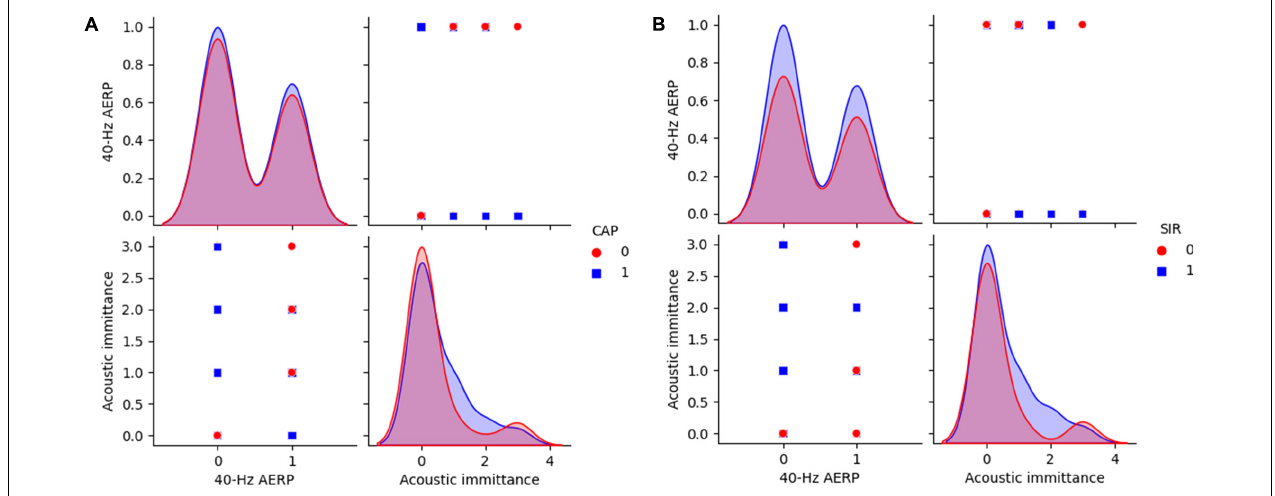
FIGURE 6 | 40-Hz AERP and acoustic immittance for CAP and SIR. (A) CAP: 0 indicates no spoken comprehension, and 1 indicates spoken comprehension. (B) SIR: 0 indicates unintelligible connected speech, and 1 indicates intelligible connected speech. CAP, categories of auditory performance; SIR, speech intelligibility